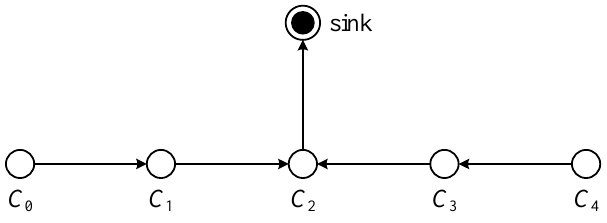
Figure 8. The Token Passing Scheme in